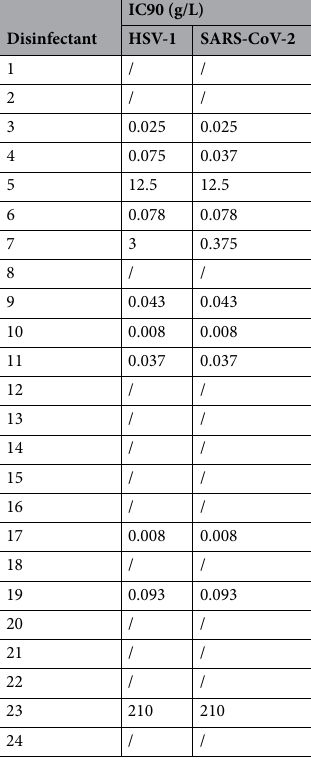
Table 4. Antiviral activity of 24 disinfectants against HSV-1 and